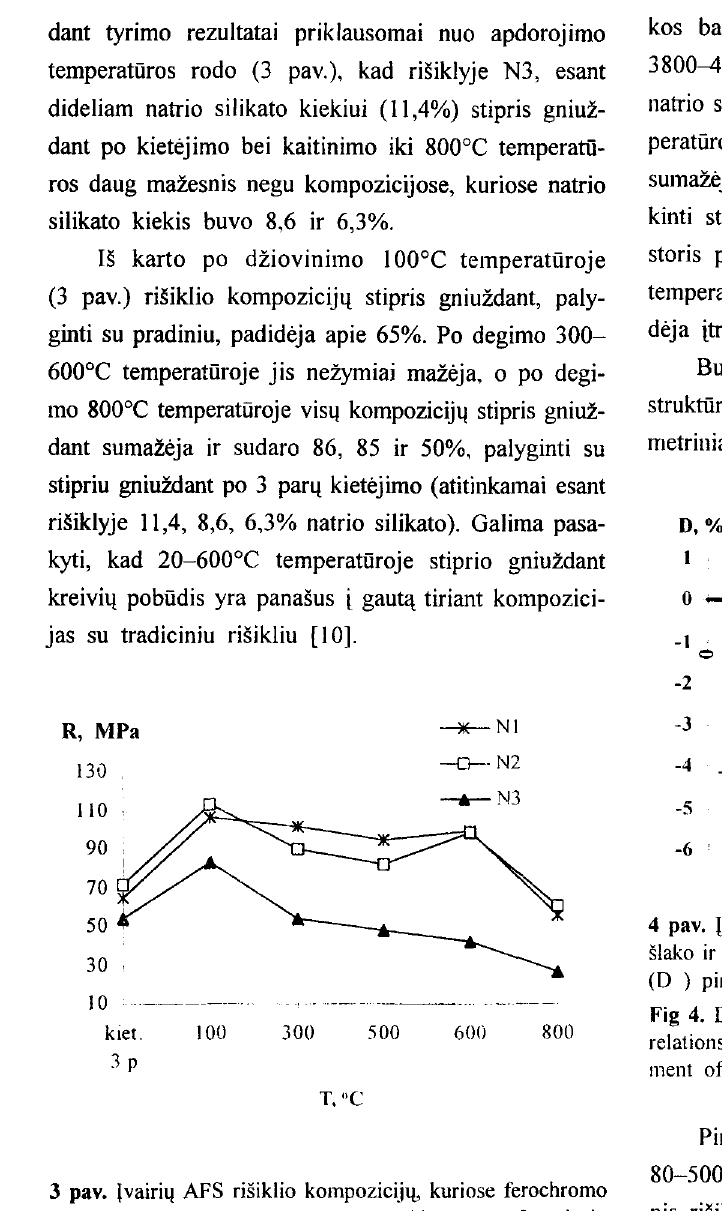
Fig 3. Compressive strength (R) of different AFS compo sitions with relationship between liquid glass hardener and alumina cement of about I :3 depending on tiring tempera